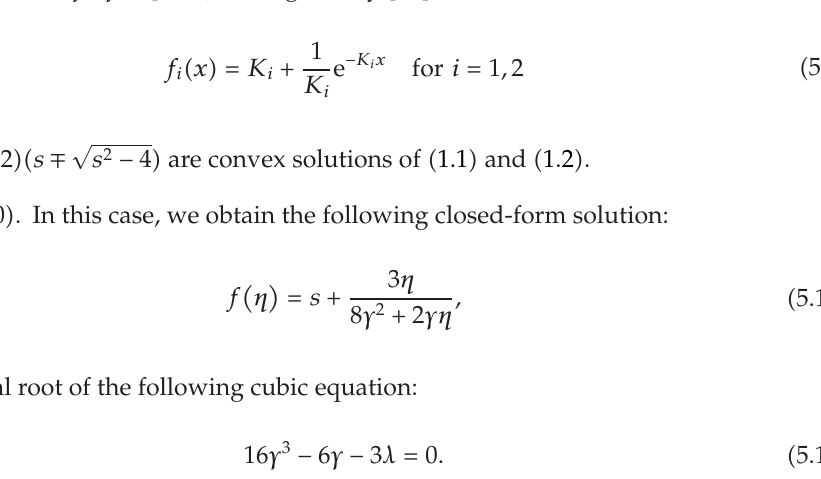
Figures 4 (cid:3) a (cid:4) and 4 (cid:3) b (cid:4) show comparison between the solution of ChPDM and G (cid:2) /G -expansion techniques for (cid:3) η, f (cid:3) η (cid:4)(cid:4) plane at m (cid:8) 0 for (cid:3) a (cid:4) s (cid:8) 1, λ (cid:8) 0 . 5 and (cid:3) b (cid:4) s (cid:8) 0, λ (cid:8) 1. In this